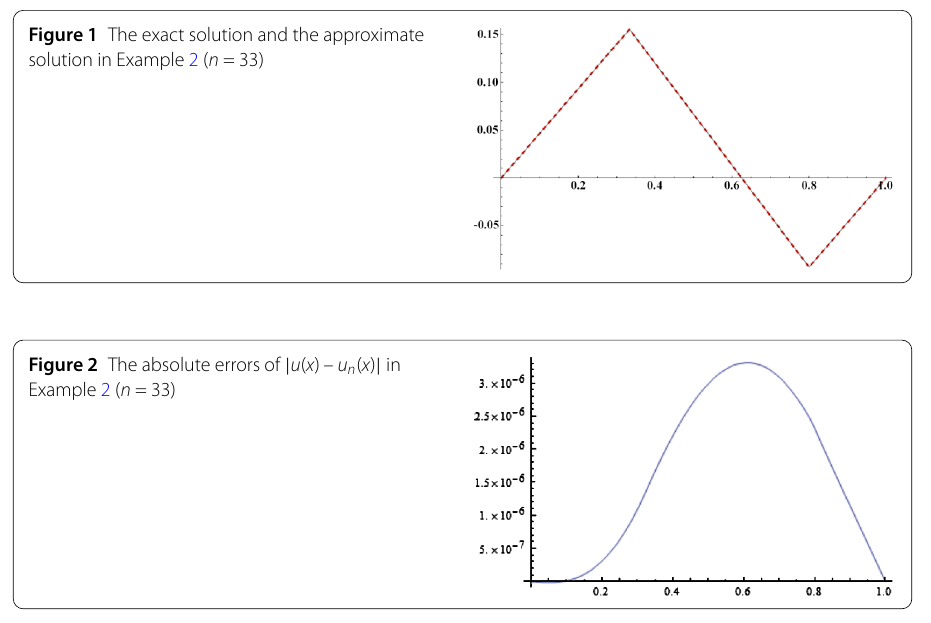
Figure 2 The absolute errors of | u ( x ) – u n ( x ) | in Example 2 ( n = 33)